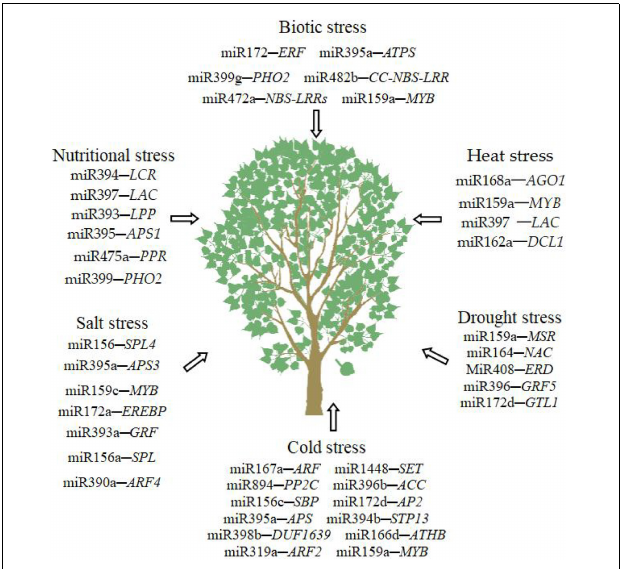
FIGURE 2 | MiRNAs involved in biotic and abiotic stresses in